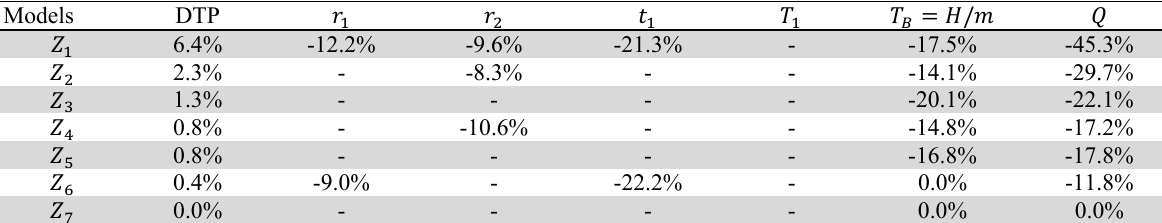
Optimal value changes (%) when TVM and shortages are considered (Example 2)